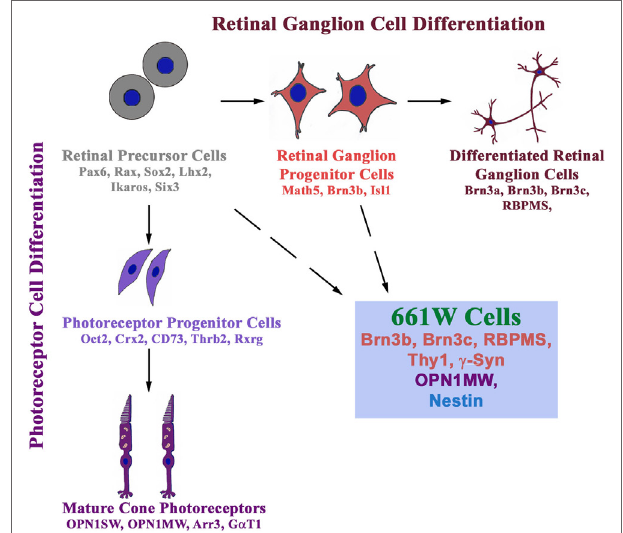
FiGURe 2 | 661W is a retinal ganglion precursor-like cell line that shows features of both retinal ganglion and cone photoreceptor cells. These cells are probably derived from either retinal precursor cells (which give rise to various types of cells in the retina) or retinal ganglion progenitor cells, which differentiate into retinal ganglion